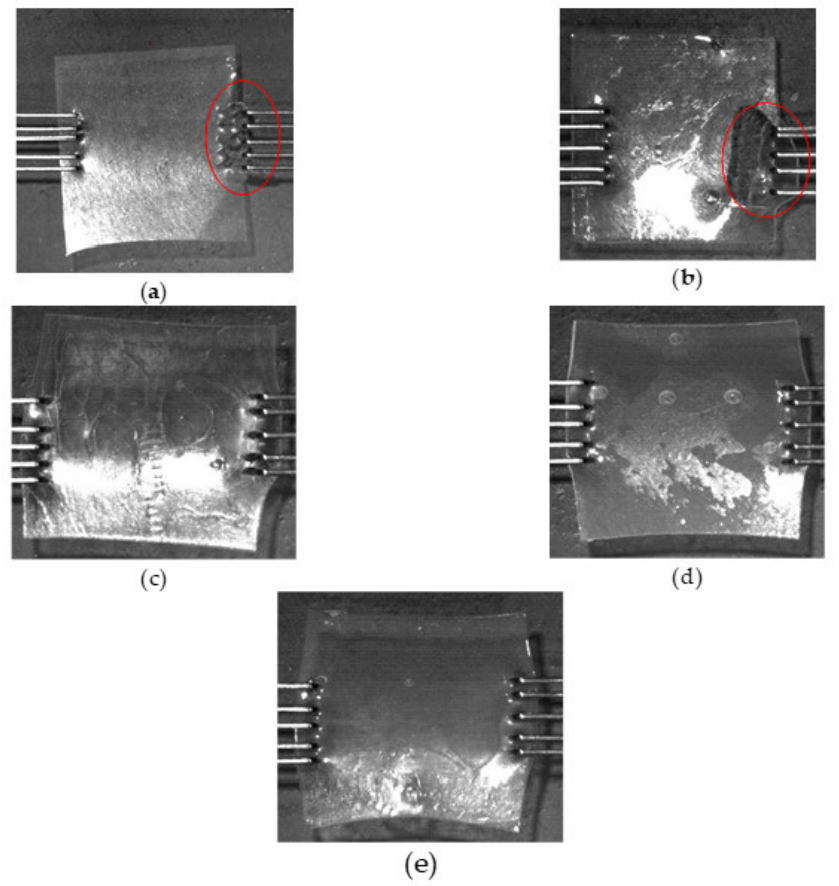
Figure 5. Images showing the end outcome of the stress–strain tests. End of test images of ( a ) 50% w/w glycerol (ruptured); ( b ) Eudragit control film (ruptured); ( c ) 50% w/w DOP; ( d ) 50% w/w [HMIM]Cl; ( e ) 50% w/w blend.